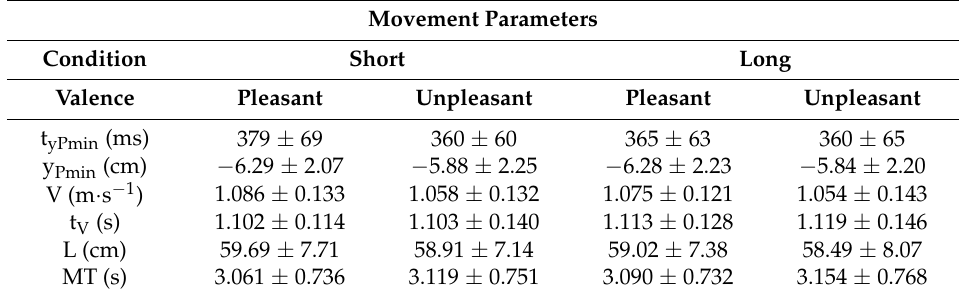
Table 1. Mean and standard deviation of the parameters measured in both conditions with pleasant and unpleasant